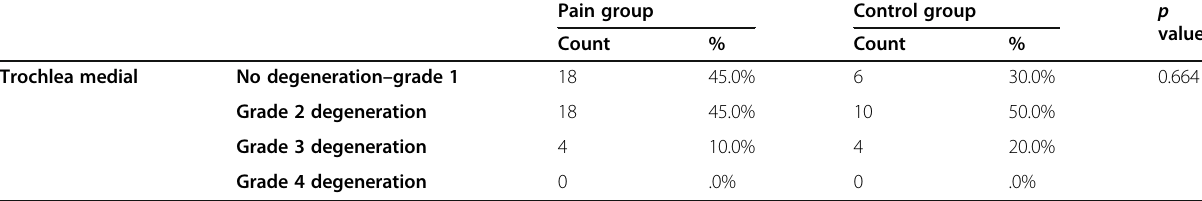
Table 3 Distribution of medial trochlear degeneration according to ICRS degeneration grades